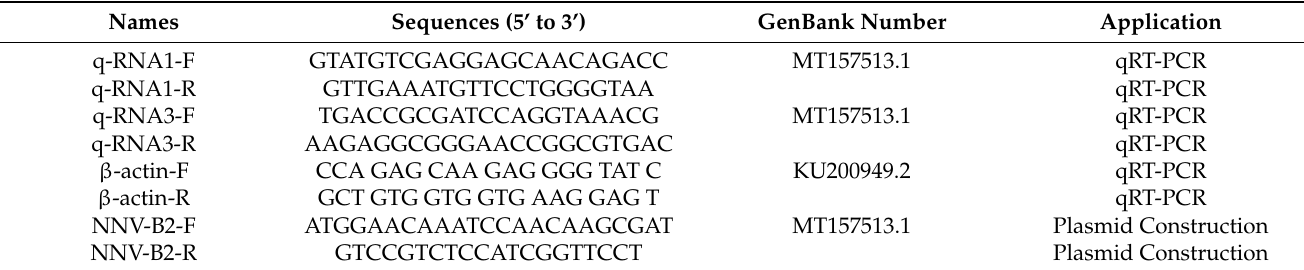
Table 1. Primers used in the present